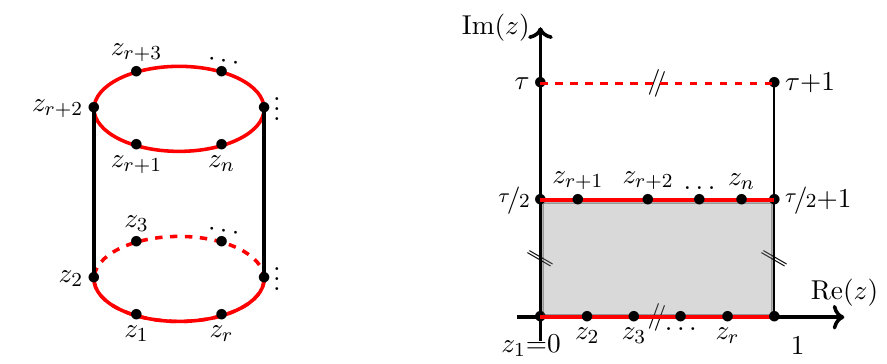
Figure 1 . The cylinder worldsheet for one-loop open-string amplitudes seen in the left panel is parameterized by the gray rectangle in the right panel, where the periodic direction is re(cid:13)ected by the identi(cid:12)cation of horizontal lines. The cylinder boundaries drawn in red are the integration domain C ( (cid:3) ) of the integrals in (1.1) where a cyclic ordering of the punctures is prescribed within both boundaries. The asterisk is a placeholder for various distributions of the punctures,